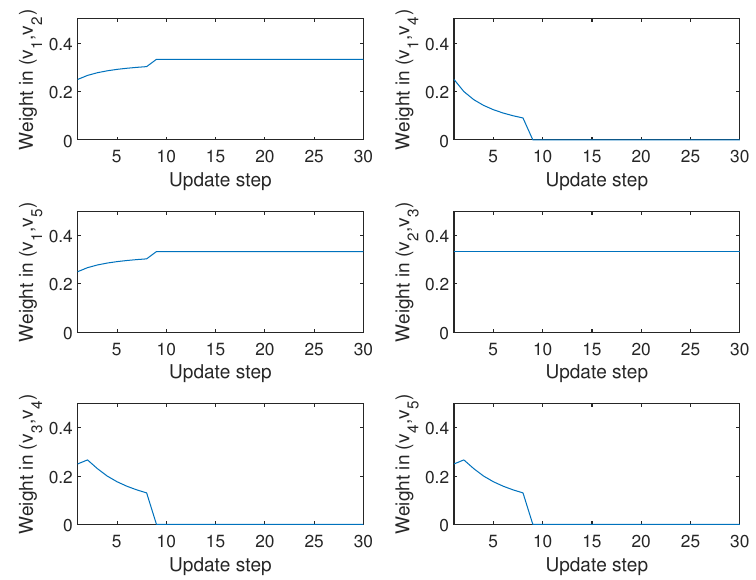
Figure 10. Edge weights update for Algorithm 3 under random